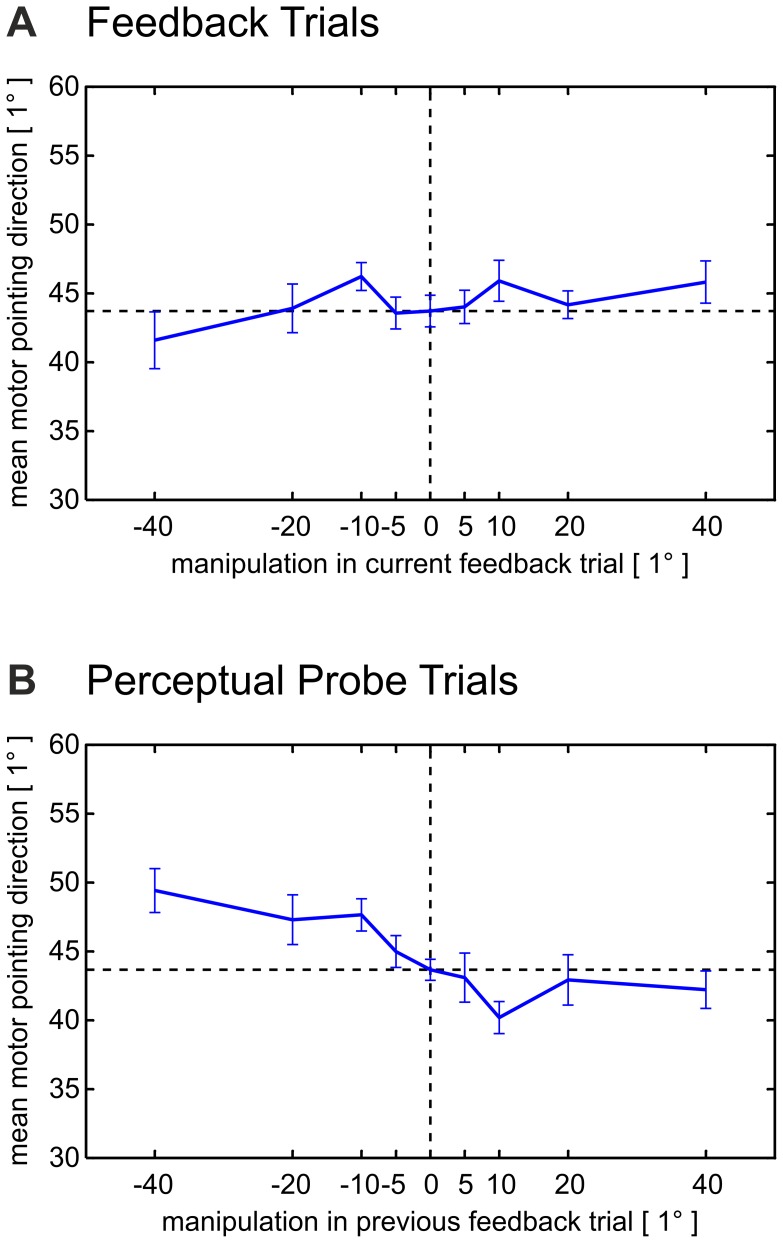
Motor pointing direction as a function of feedback manipulation.
(A) Feedback trials. The mean motor pointing direction in feedback trials (mean ± standard error) is plotted as a function of the visual manipulation, with 0° representing the rightward direction and 90° representing the anterior direction. Subjects showed no systematic online correction of their movement trajectories when presented with deviating visual feedback. (B) Perceptual probe trials. The mean motor pointing direction in perceptual probe trials (mean ± standard error) is plotted as a function of the visual manipulation applied in the preceding feedback trials. Subjects adjusted their motor performance in a manner which compensated for the recalibrated visual movement consequences (compare Figure 3C). Positive angles denote counterclockwise rotations. For the density distribution of the motor pointing direction in space, compare Figure S2.